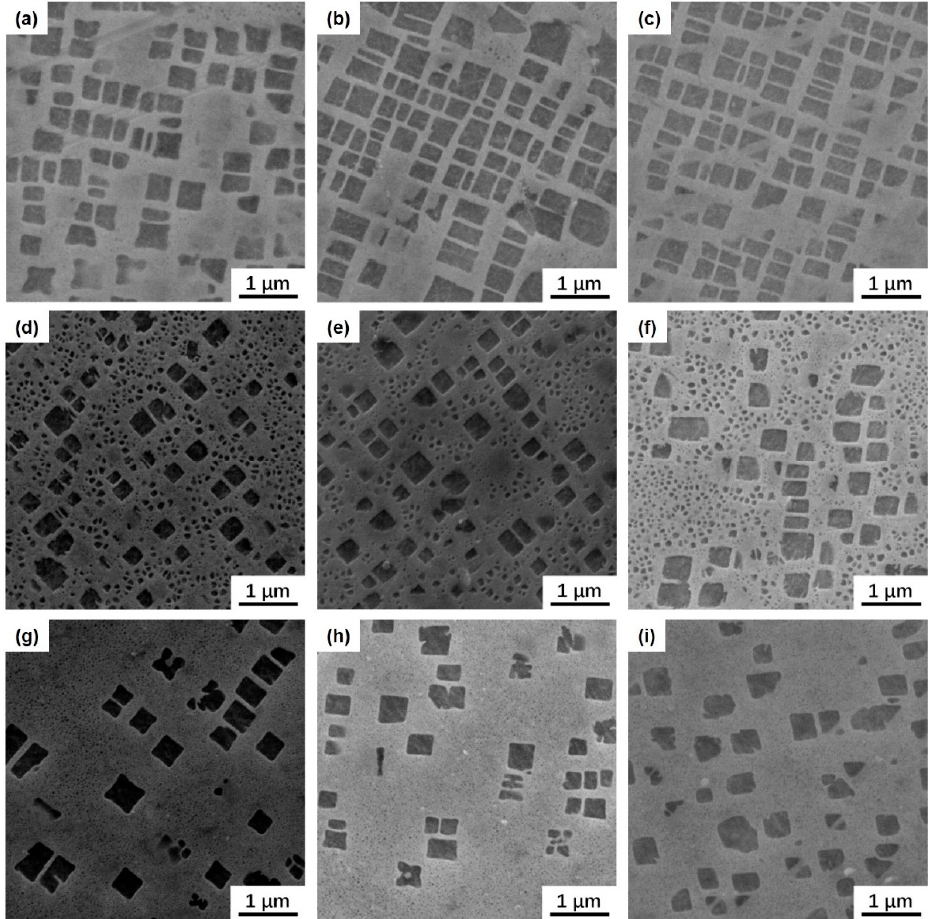
Figure 8. Microstructures near the fracture plane; the plane parallel to the tensile axis is displayed: ( a – c ) Furnace cooling; ( d – f ) Air cooling; ( g – i ) Oil quenching; ( a , d , g ) About 6 mm away from the fracture plane; ( b , e , f ) About 3 mm away from the fracture plane; ( c , f , i ) Near the fracture plane.